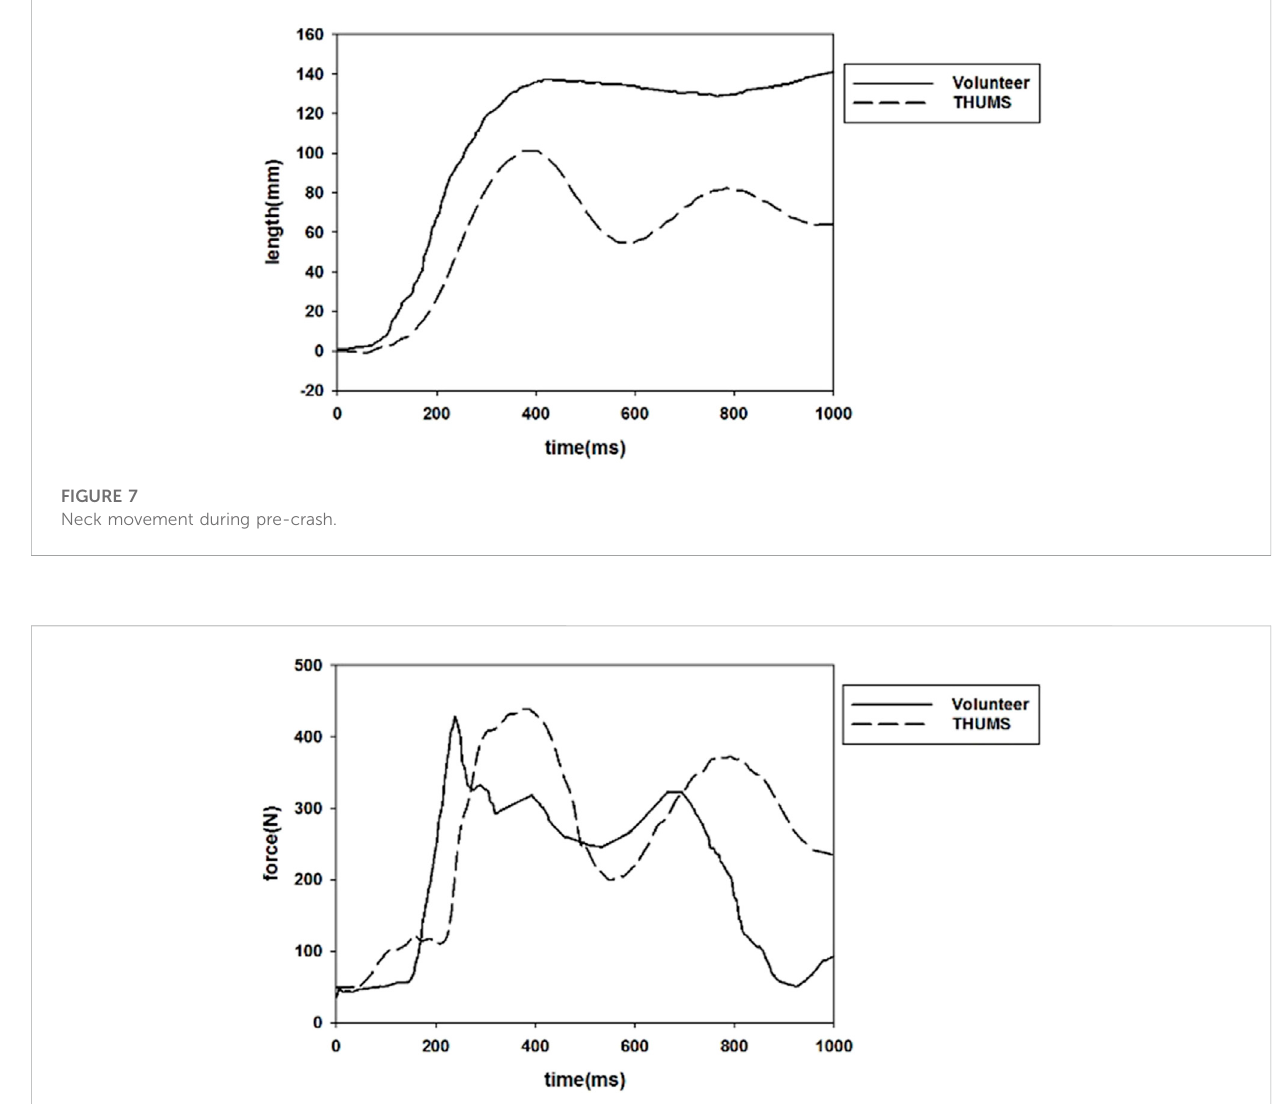
FIGURE 8 Shoulder belt force during